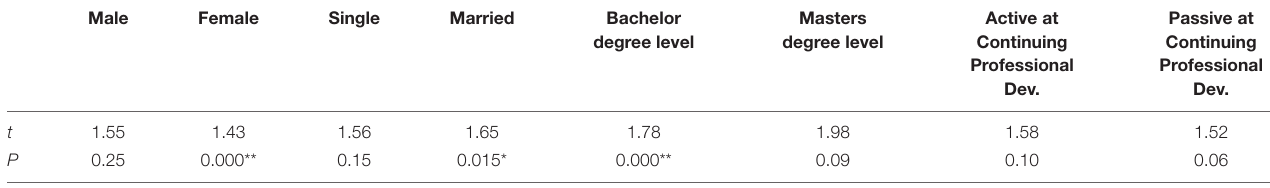
TABLE 5 | Individual t -tests on demographic characteristics before and after COVID-19 pandemic conditions. Male Female Single Married Bachelor